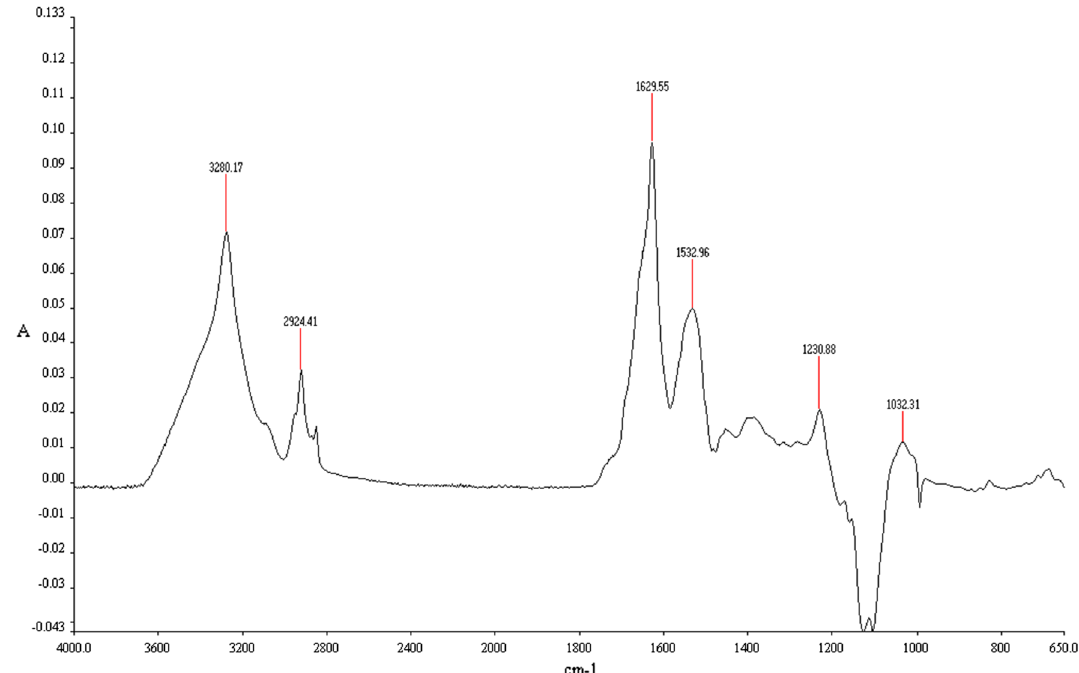
Fig. 8 Difference ATR/FTIR spectra of Hydranautics